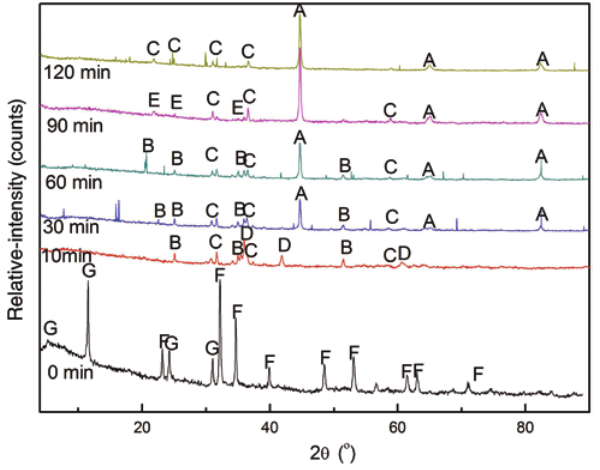
Figure 5: XRD pattern of the samples with different reduction times at 1000 °